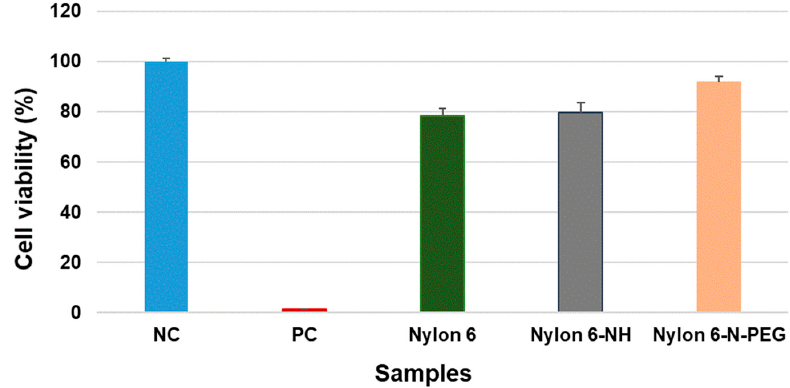
Figure 8. Metabolic activity of fibroblasts after 24 h of incubation in a complete medium (NC), medium + Triton X-100 (PC), in a complete medium with the presence of the tested samples. The red line refers to the cytotoxic level according to ISO 10993-5:2009.